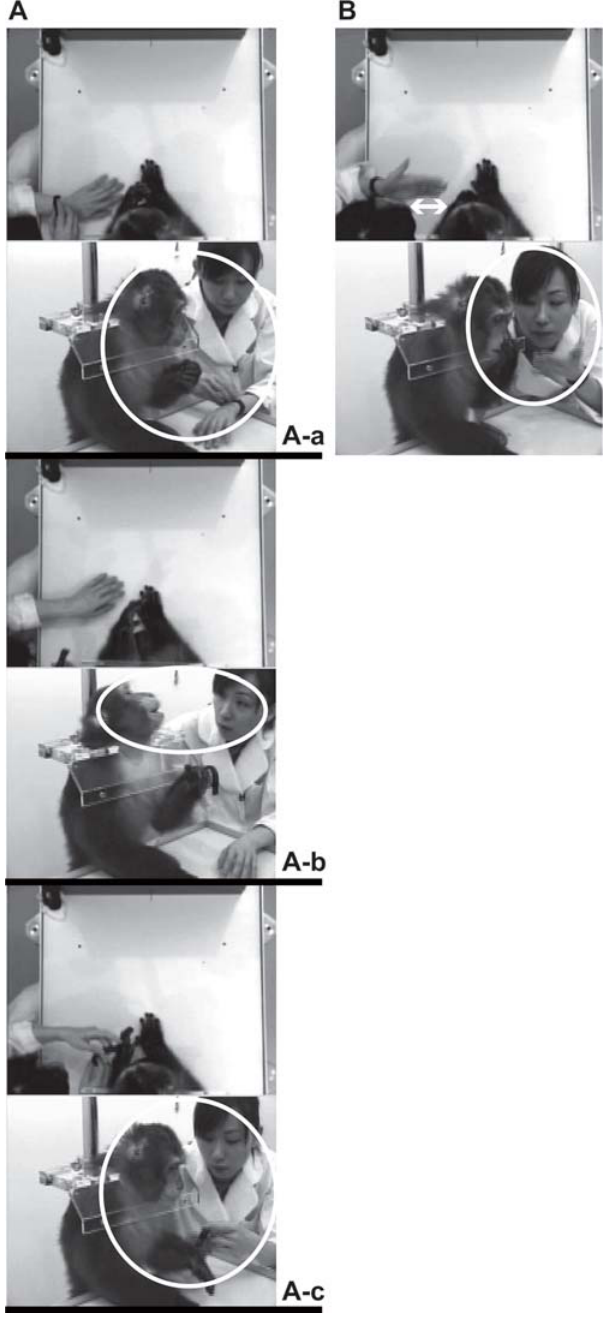
Figure 1. The top and front views during the imitation training. The views showing joint attention during the imitation training (A). The experimenter noticed that the monkey looked at her wrist watch (A-a), and then she also looked at and manipulated it (A-b). Finally, the experimenter put her watch on his arm (A-c). The views showing moving his hand to touch his face (B).